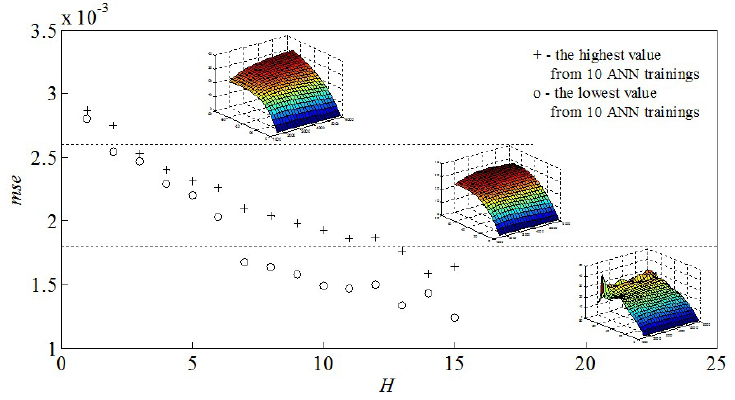
Figure 7. Mean squared error vs. hidden neurons number H. 197